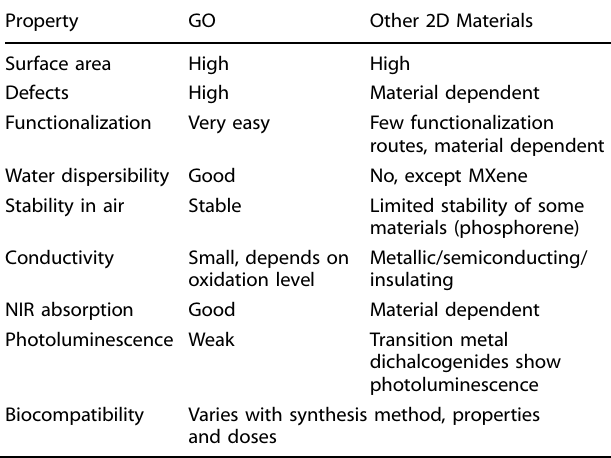
Fig. 4 Graphene-based materials. The structures of pristine graphene (with sp 2 -hybridized carbon atoms), GO (chemically modi fi ed graphene), and rGO (reduced graphene oxide). Table 2. Comparison of GO and other 2D materials for cancer detection